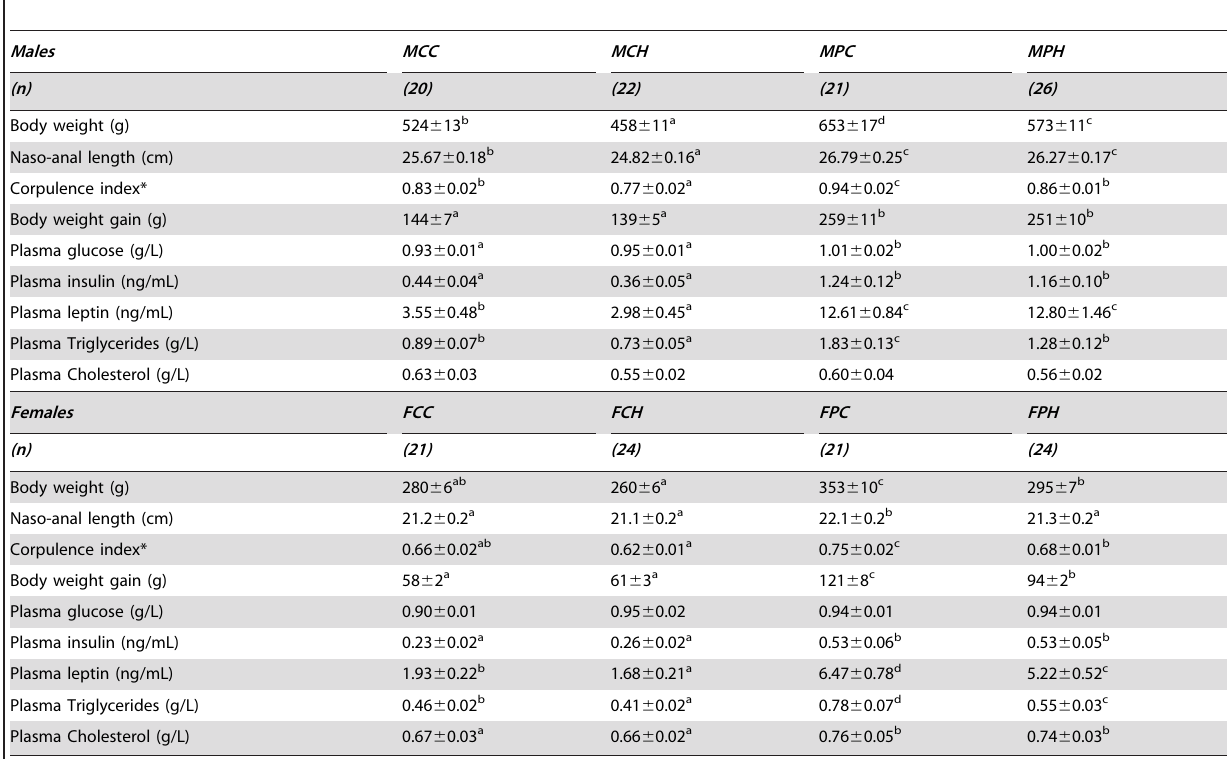
Table 4. Corpulence and plasma parameters measured in male and females offspring of dams fed the control or high-fat diet (C or H as 3 rd letter) after feeding the control or highly palatable diet (C or P as 2 nd letter) for three months.